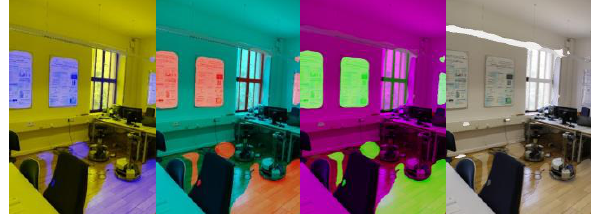
Figure 7. Combination of original images and the segmented images with a background value of 0. From left to right: As replacement of the Blue channel, as replacement of the Red channel, as replacement of the Green channel, as additional fourth channel acting as transparency